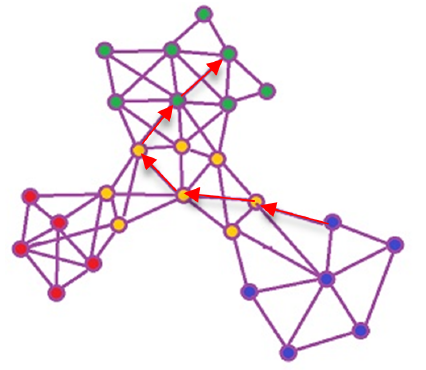
Figure 2. Moving through a network of